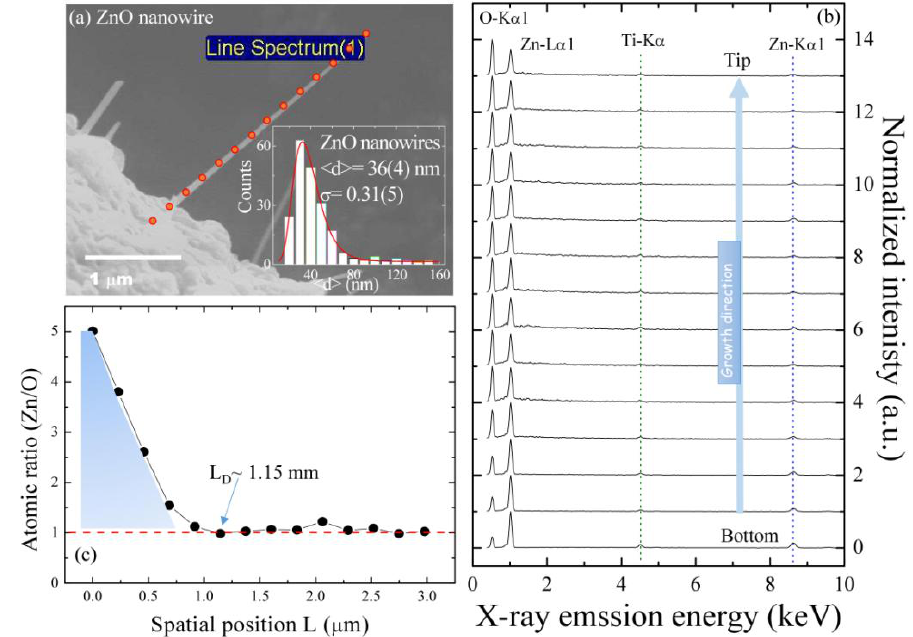
Figure 2. ( a ) Field-emission scanning electron microscopy (FE-SEM) image of a single ZnO NW; ( b ) corresponding energy dispersive spectroscopy (EDS) spectra along the growth direction; and ( c ) the atomic ratio Zn/O versus the position. The inset to ( a ) shows the diameter distribution taken from a portion of the SEM image.